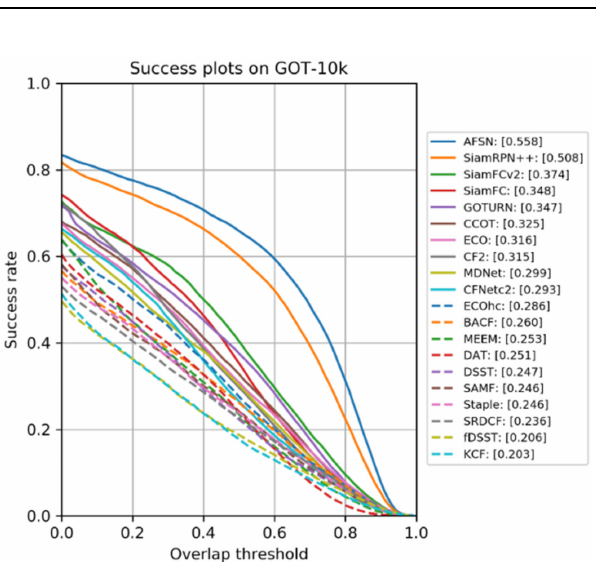
Figure 3. Comparisons on GOT-10k (Generic Object Tracking Benchmark). Our AFSN signifi- cantly outperforms other methods. AFSN: Anchor-Free Siamese Network; SiamRPN++: